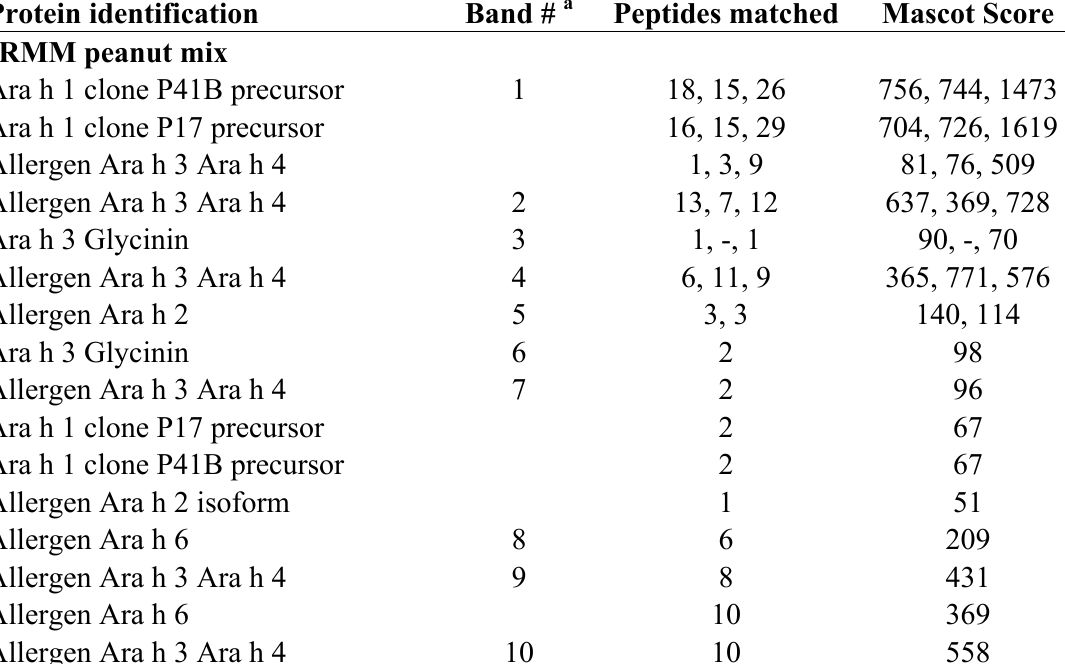
Table 3. Tryptic peptides identified from IRMM peanut mix and 16 min baked cookies incurred with 100,000 μ g peanuts g − 1 matrix of IRMM peanut